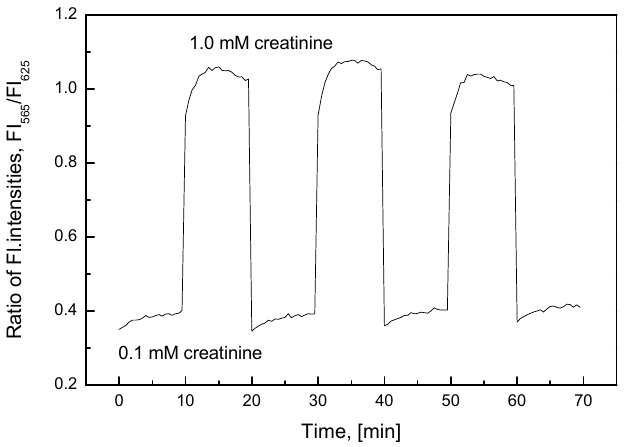
Figure 8. Reversibility of the creatinine-sensing membrane at 0.1 and 1.0 mM creatinine.